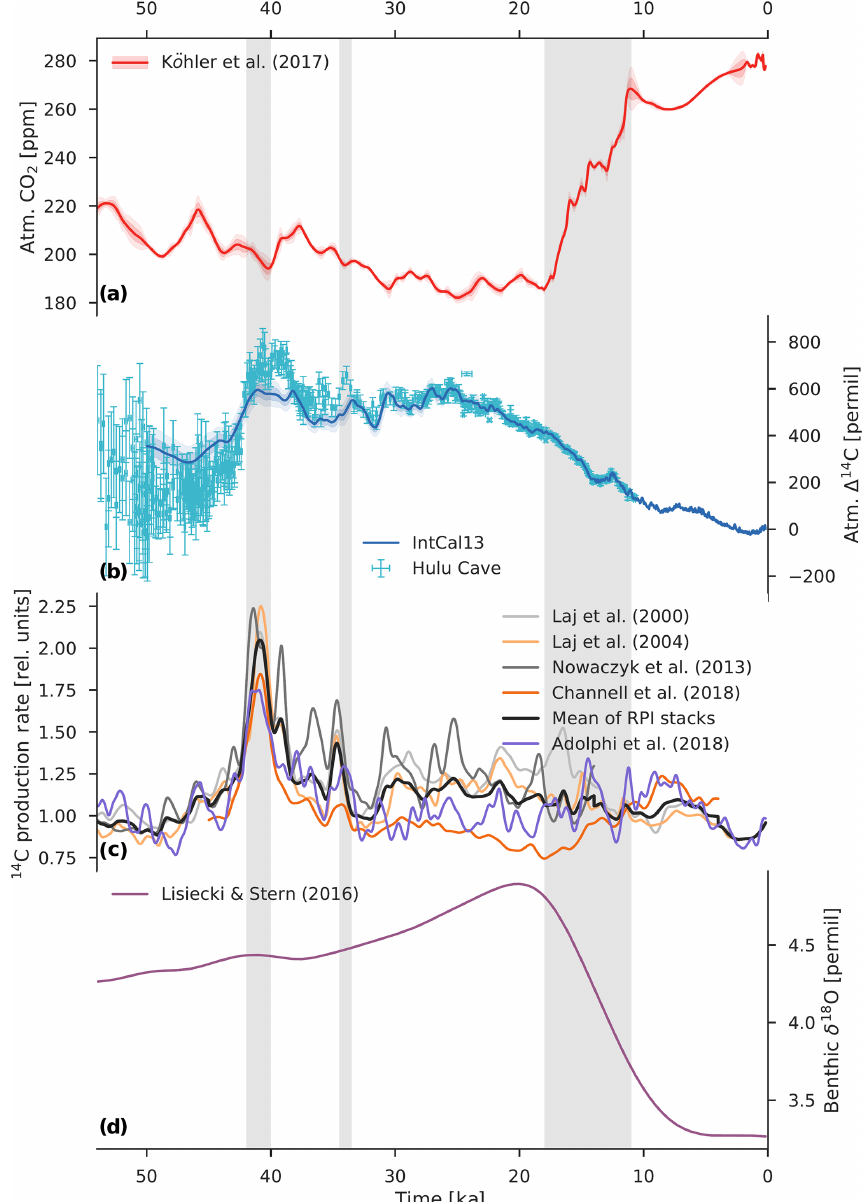
Figure 1. Comparison of various paleoclimate records for the last 54kyr. (a) Atmospheric CO 2 from the data compilation of Köhler et al. (2017). The light red envelope shows the uncertainty (2 σ ). (b) Atmospheric (cid:49) 14 C reconstructed from 14 C measurements on tree rings, plant macrofossils, speleothems, corals, and foraminifera. The light blue envelope shows the uncertainty (2 σ ) in the IntCal13 cali- bration curve (Reimer et al., 2013), whereas the Hulu Cave data (Cheng et al., 2018) are shown with error bars (1 σ ). Hulu Cave data are consistent with IntCal13 between ∼ 10 . 6 and 33.3ka. For both records (cid:49) 14 C values were adjusted to the presently accepted value of the radiocarbon half-life (5700 years). (c) 14 C production rate in relative units reconstructed from paleointensity data (Laj et al., 2000, 2004; Nowaczyk et al., 2013; Channell et al., 2018) and from polar ice-core 10 Be fluxes (Adolphi et al., 2018). The heavy dark gray line is the mean paleointensity-based 14 C production rate. (d) Global benthic δ 18 O stack, a proxy for ice volume, from Lisiecki and Stern (2016). Three vertical light gray bars indicate the Laschamp excursion ( ∼ 41ka) when the Earth’s geomagnetic dipole field intensity was close to zero, the Mono Lake geomagnetic excursion ( ∼ 34ka), and the last glacial termination ( ∼ 18 to